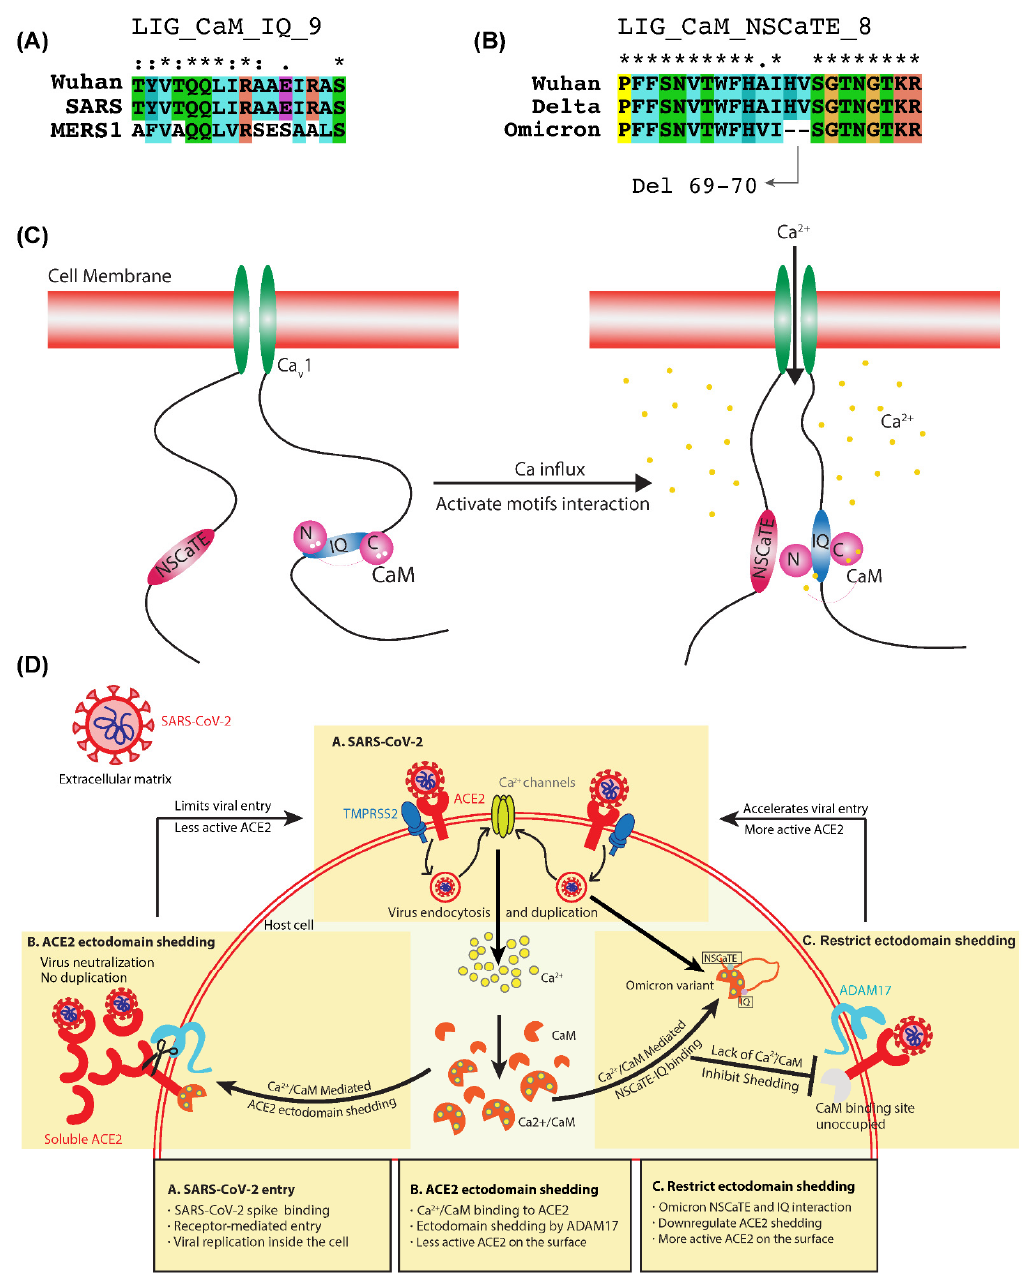
Figure 4. The interaction of NSCaTE and IQ motifs in a Ca 2+ /CaM-mediated manner. Snapshot of the multiple sequence alignment of spike proteins from ( A ) SARS-CoV-2 (Wuhan), SARS1, and